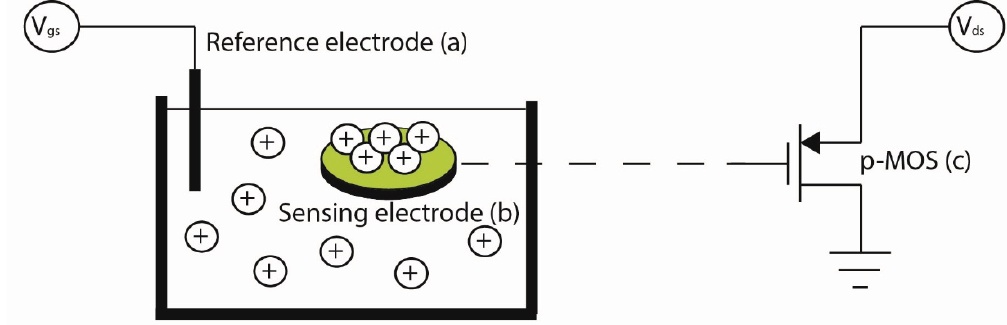
Figure 1. Schematic of the pH sensing